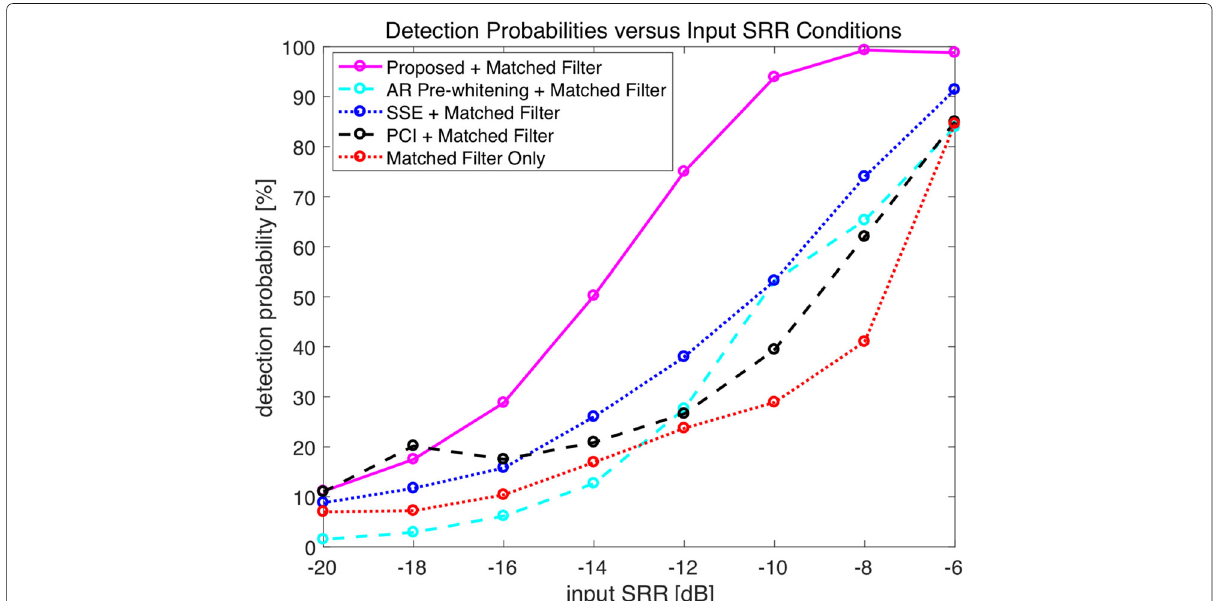
Fig. 11 Detection probabilities versus input SRR conditions at a false alarm probability of 1%